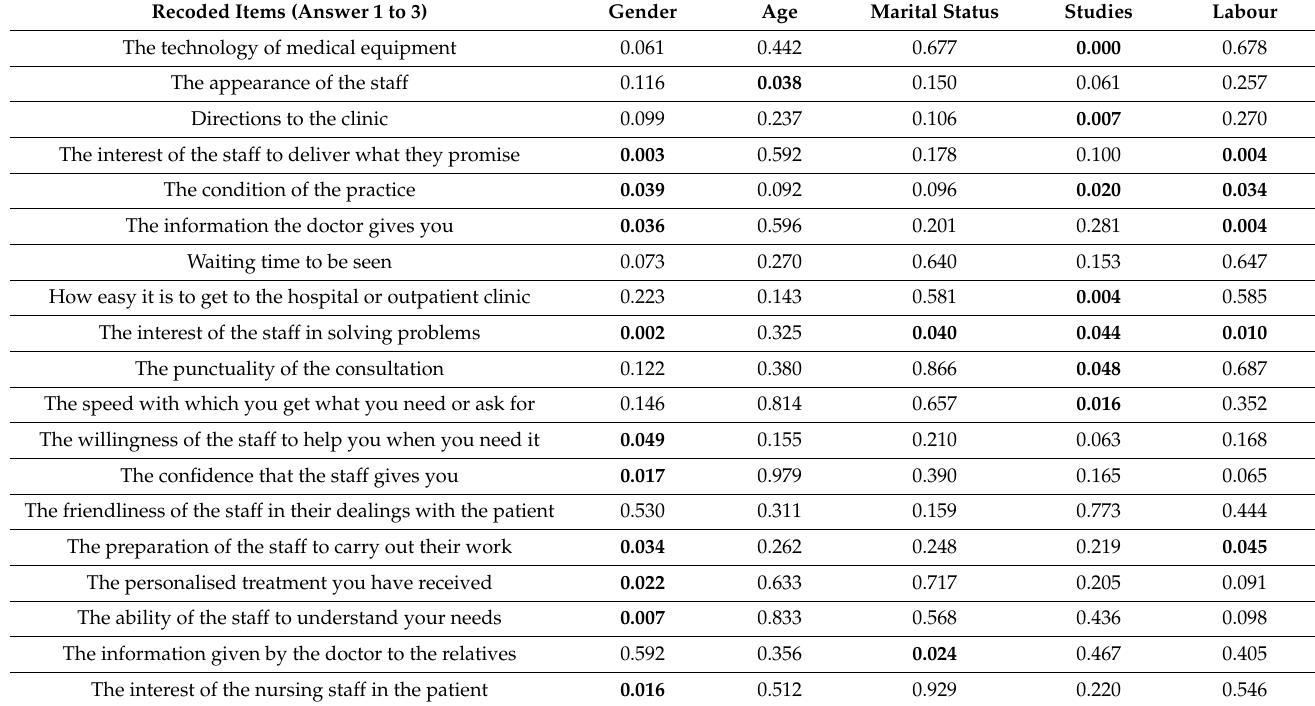
Table 5. Analysis of the influence of the 19 recoded items with the recoded demographic